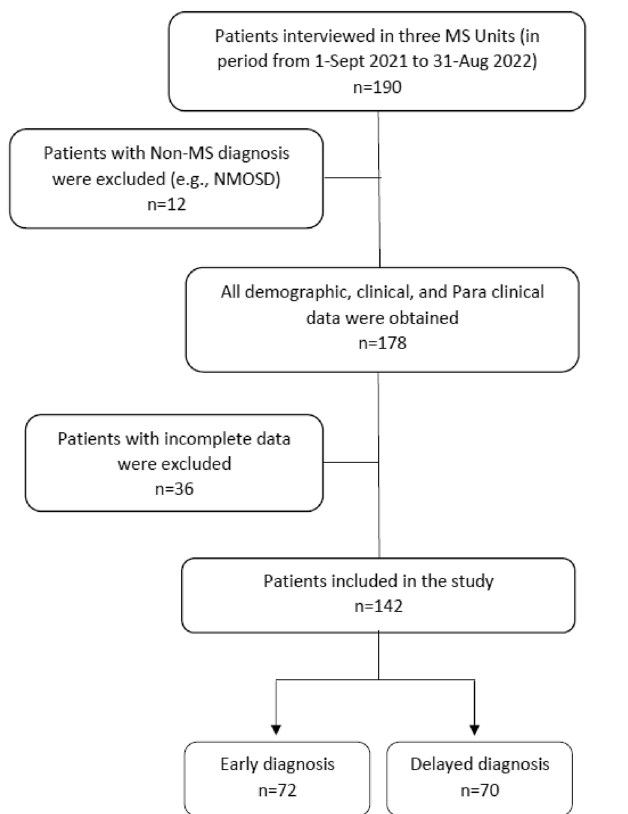
Figure 1. Flowchart of patient